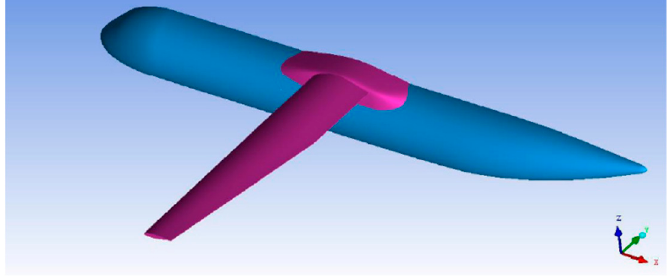
Figure 28. Aircraft configuration examined in Ref. [110]. Table 8. Weight savings for a design mission with cruise phase of 900 nmi and 350 nmi [110].